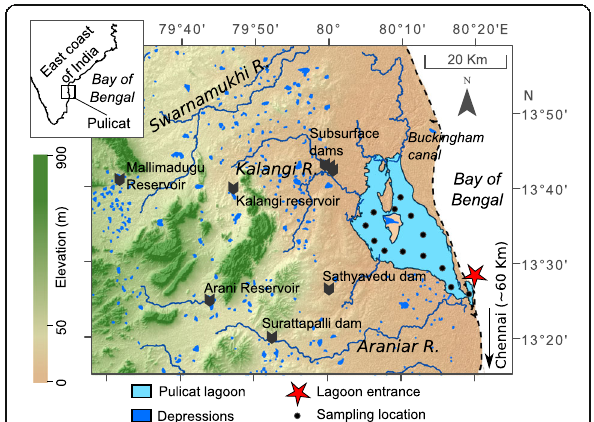
Fig. 1 Pulicat lagoon (filled with cyan) is shown with regional topography derived using CARTOSAT DEM and the major water bodies (marked in blue) of the drainage basin. The river channels (Araniar, Kalangi and Swarnamukhi) are indicated with blue lines. Major dams are marked with black pointers (from Raju et al. 2006, Raju et al. 2013, Sprenger et al. 2015). Entrance of the lagoon into the Bay of Bengal is presently active only near the southern region of the lagoon (marked with a red star). The sampling locations used in the present study for surface salinity are denoted by black